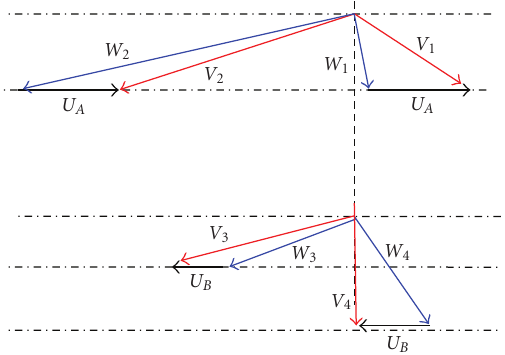
Figure 3: Velocity triangle